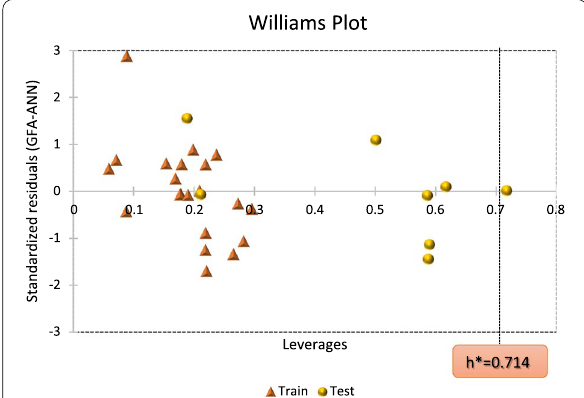
Fig. 5 Scatter plot of the standardized residuals of the GFA-ANN model against leverage scores (Williams plot)